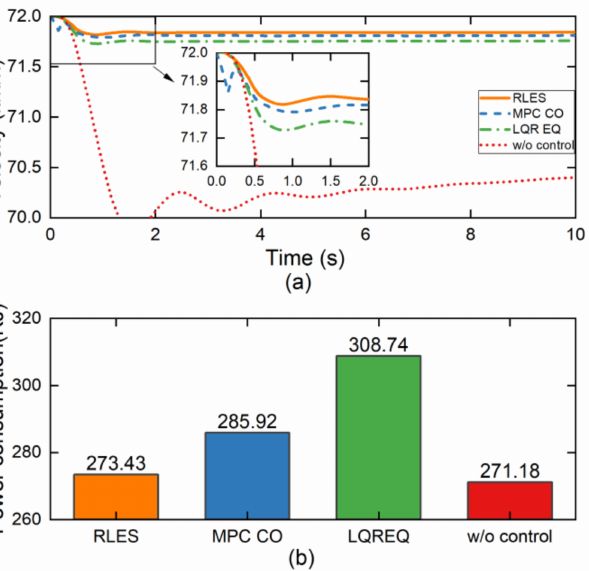
Figure 13. Simulation results under step steering maneuver. ( a ) Longitudinal velocity; ( b ) motor power